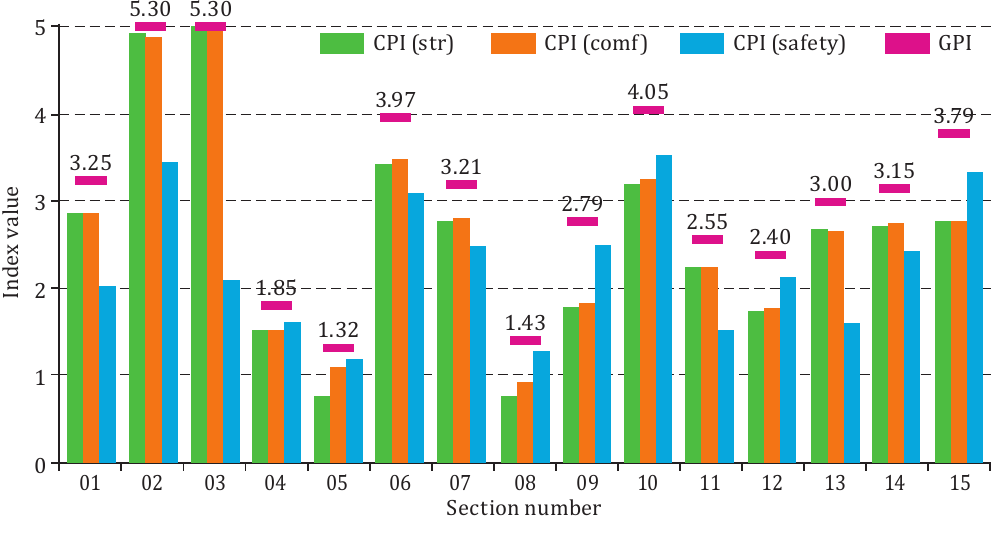
Figure 2. Comparison of the combined performance indicators (structural, comfort and safety) as well as global performance indicator (based on the methodology by the Lithuanian Road